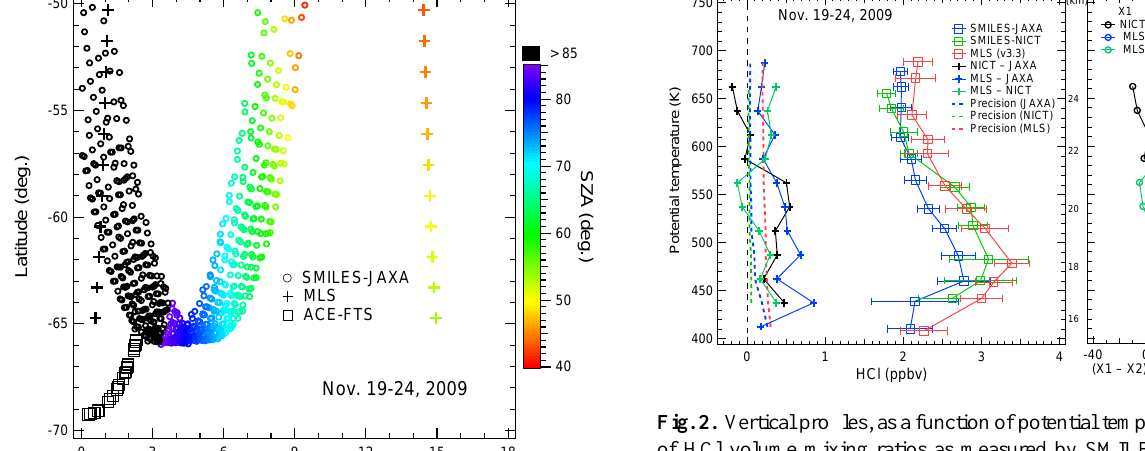
Fig. 2. Vertical profiles, as a function of potential temperature (PT), of HCl volume mixing ratios as measured by SMILES and MLS on 19–24 November 2009 inside the vortex (within the edge cen- ter). The left panel shows average profiles of HCl in each 25K PT bin (each vertical bar corresponds to 25K) for the SMILES- JAXA (blue), SMILES-NICT (green), and MLS (red) data prod- ucts. Squares and horizontal bars show average and ± 1 σ stan- dard deviations, respectively. Dashed lines show reported preci- sions. The black crosses show the absolute difference between the two SMILES products. The blue and green crosses show the abso- lute difference between the MLS and SMILES-JAXA or SMILES- NICT, respectively. Approximate altitudes corresponding to PT are shown on the right-hand side of the panel. The right panel shows the relative difference with regard to the absolute difference divided by its mean value of SMILES-JAXA and SMILES-NICT, MLS and SMILES-JAXA, or MLS and SMILES-NICT products. The num- bers of data used in the averages are also listed outside of the right panel: SMILES-JAXA (blue), SMILES-NICT (green), and MLS